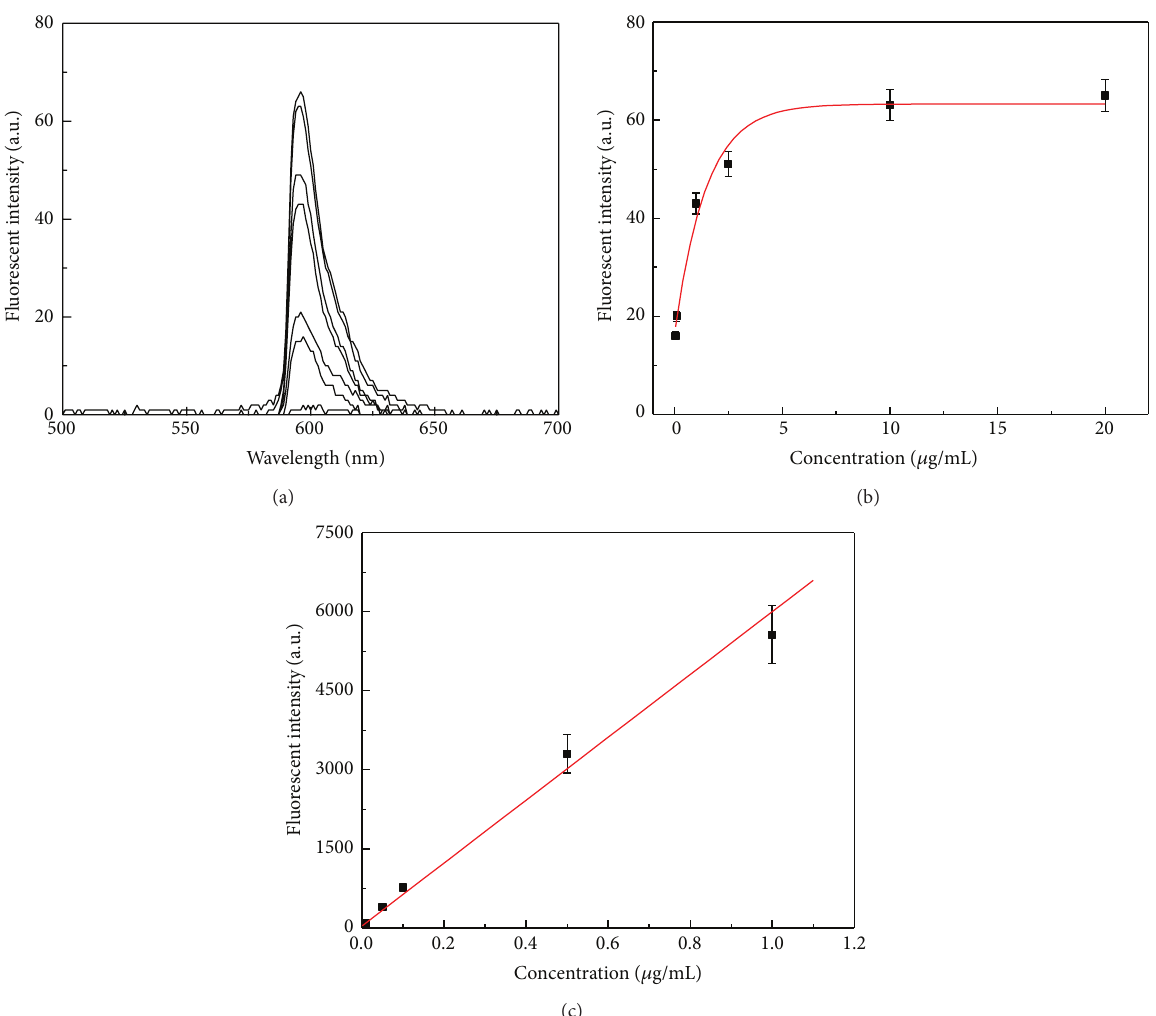
Figure 7: The antigen detection fluorescent intensities (a) and the relation between intensities and higher concentrations (b) and lower concentration (c). For (a) and (b) the exposure time was 600ms and for (c) it was 8000 ms.